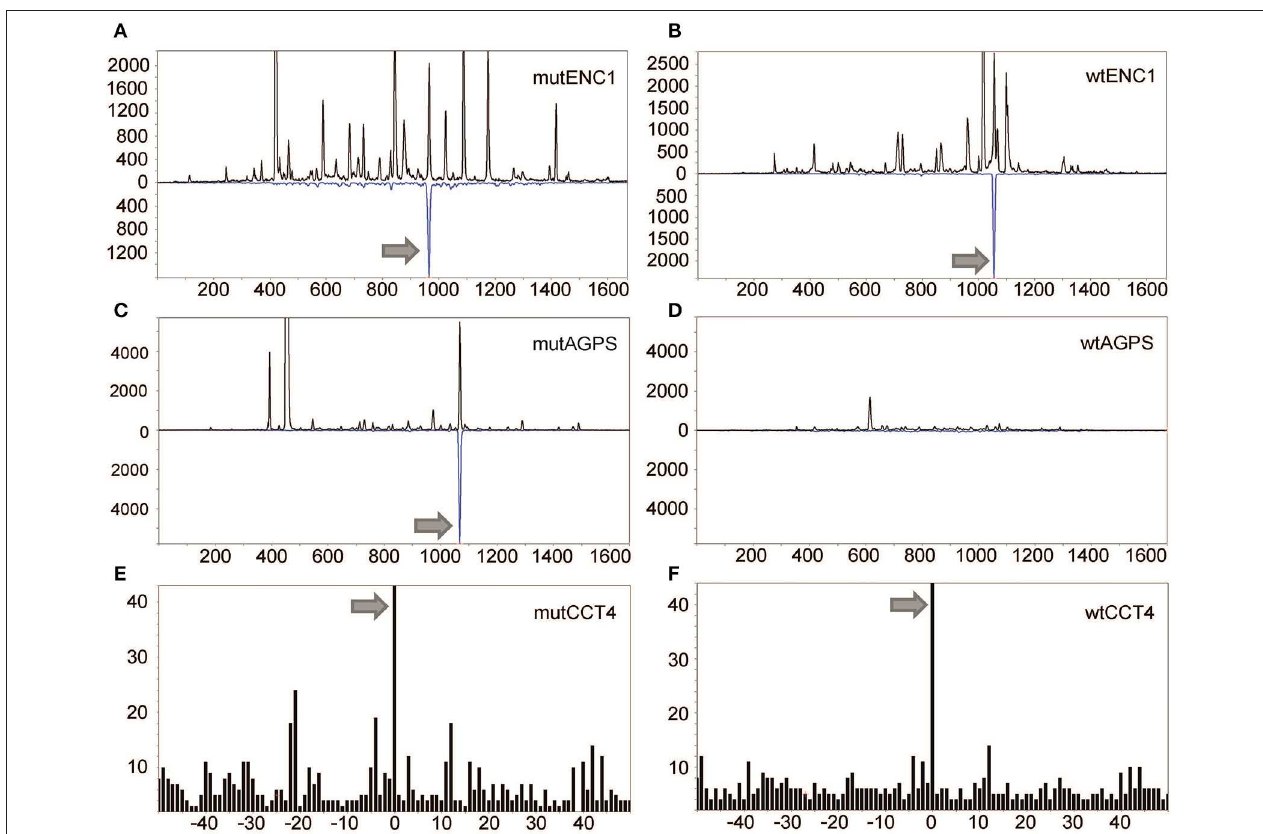
FIGURE 2 | Detection of mutated peptides presented on the tumor cell surface. LC-DIAMS Poisson detection plots for neoepitopes from mutated (A) and wild-type (B) ENC1 and mutated (C) and wild-type (D) AGPS from 500,000 cells. Top black traces are extracted ion chromatograms for m / z of the doubly charged precursor ion in units of counts per second . The inverted traces (blue) are Poisson chromatograms showing the number of events, scaled 10-fold (as a convenience in plotting), that can be embedded at fixed cutoff probability in the MS/MS spectrum of the DIA window containing the precursor m / z (17). Nanospray MS3 Poisson detection of cysteine-containing neoantigen peptide CCT4 (E) or the corresponding wild-type peptide (F) was performed from 1.5 million cells, as marked with a 0-offset Poisson peak (